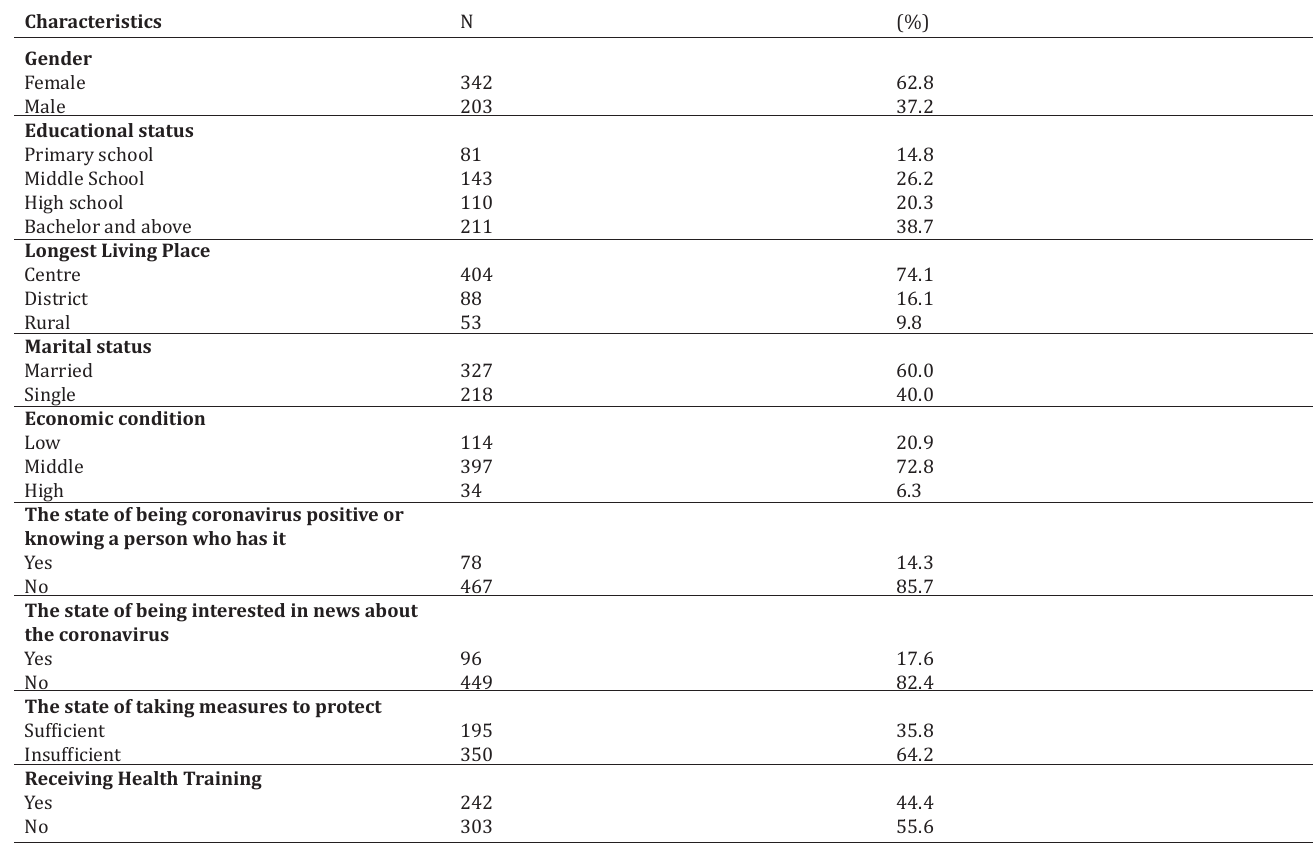
Demographic characteristics of the participants